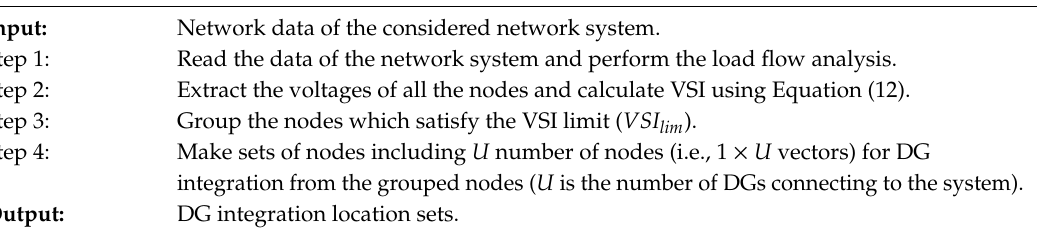
Algorithm 1. Identification of nominee locations for DG integration.